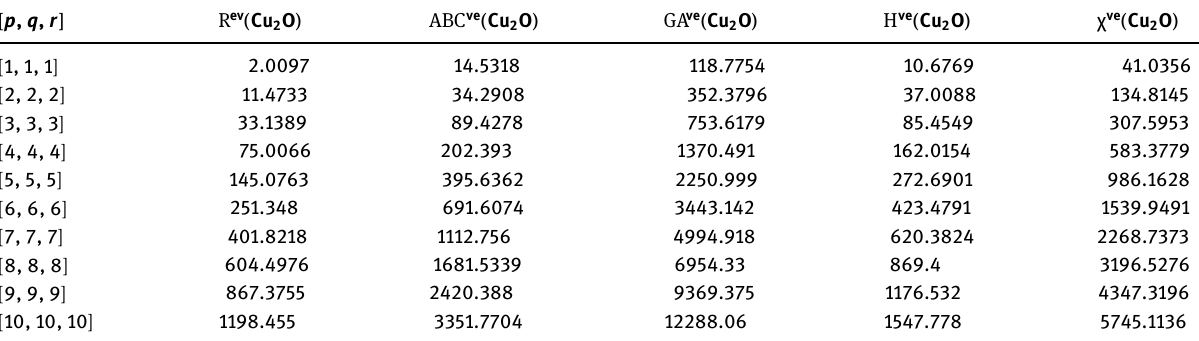
Table 5: Numerical representation of the computed indices for certain values of Cu O 2 [ ] p q r ,